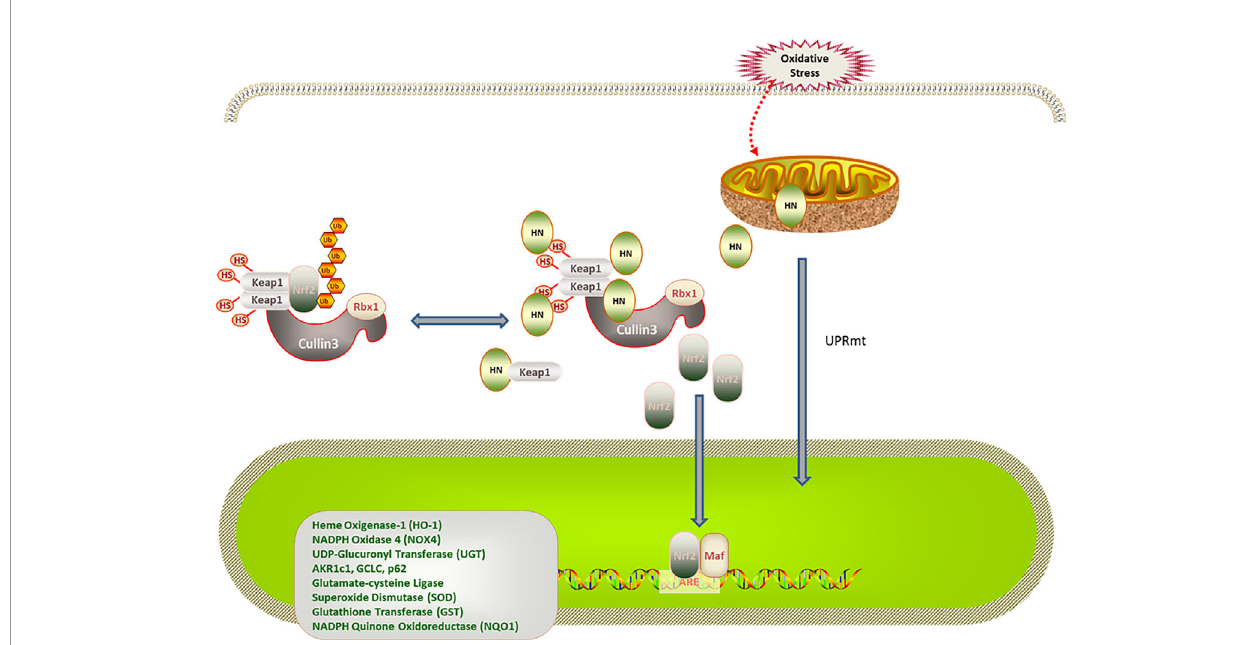
FIGURE 2 | Regulation of HN on Keap1/Nrf2 signaling pathway under oxidative stress. HN promotes Keap1 degradation and release of Nrf2. Under stress conditions, HN inhibits the expression of Keap1, promotes the dissociation of Nrf2 and Keap1, activates the expression of antioxidant genes (SOD, CAD, HO-1, NQO1), and protects mitochondria from oxidative stress damage. Stress also triggers UPRmt, promotes the expression of antioxidant genes and the recovery of mitochondrial function, further promoting the formation of